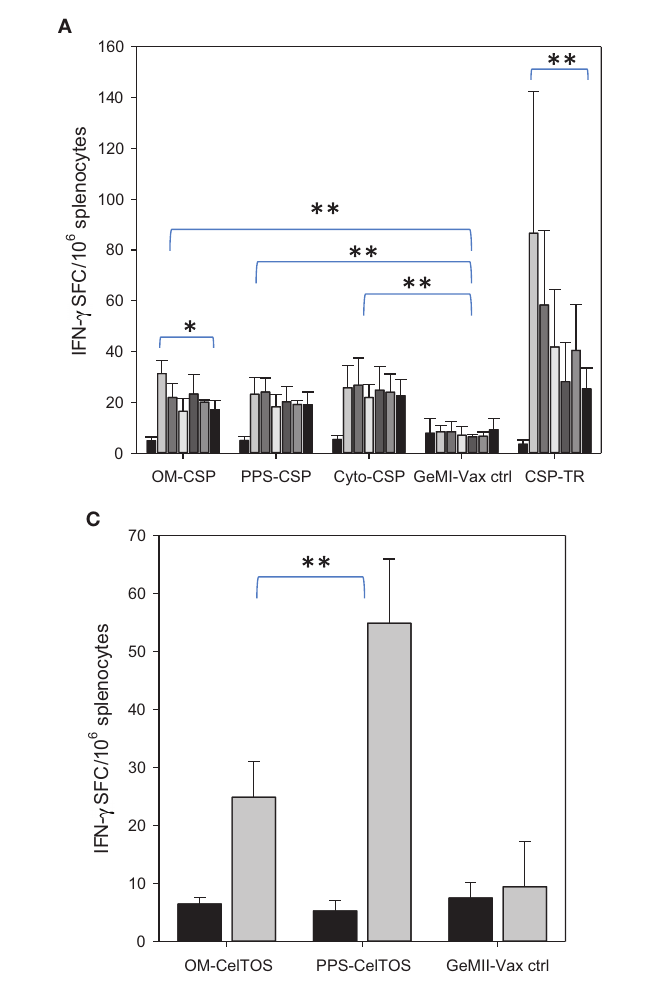
FIGURE 6 | E. coli GeMI-Vax induceTh1 but notTh2 responses . GeMI-Vax constructs (indicated on the X -axis) were tested for their ability to mount antigen-specific IFN- γ responses (A,C) , and IL-4 responses (B,D) after antigen-specific stimulation. (A,B) Splenocytes stimulated ex vivo with either recombinant Pb CSP (10 µ g/mL) or Pb CSP-derived peptides (peptide mix = pool of all four peptides, peptides CS 57-70 and CS 242-279 represent